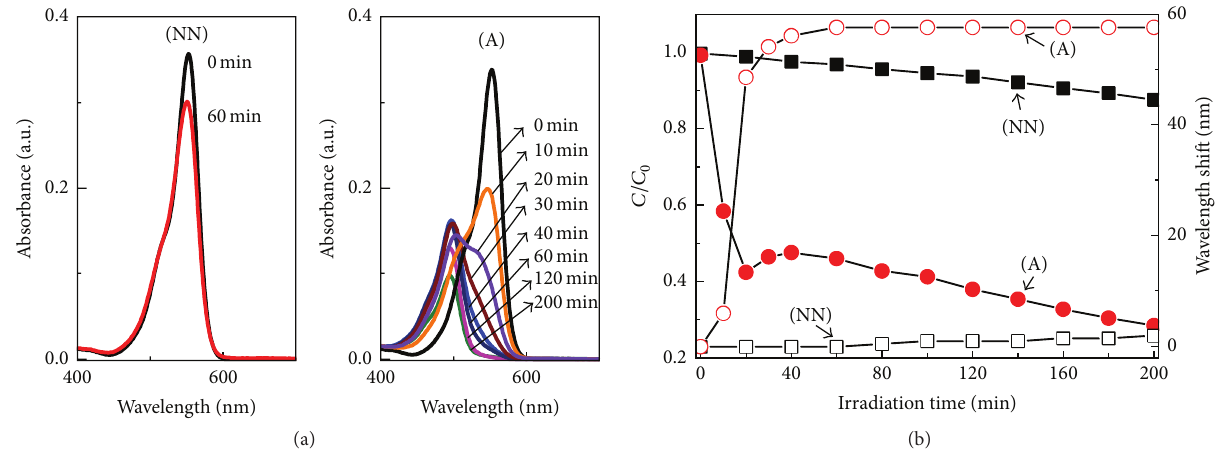
Figure 5: (a) Temporal changes of RhB absorption spectra in presence of NN and A under visible light irradiation ( 𝜆 > 420 nm). (b) Variation in 𝐶/𝐶 0 (solid square and spot) and wavelength shift (empty square and cycle) over NN and A under visible light irradiation.